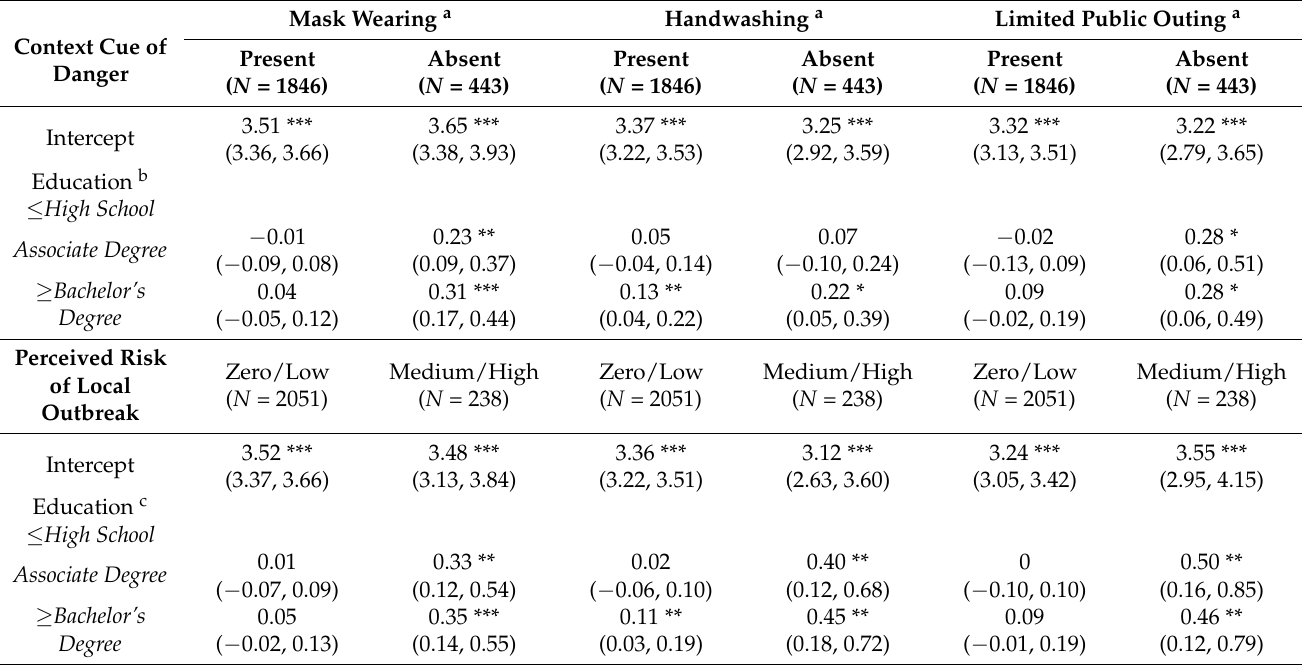
Table 4. Educational Disparities in COVID-19 Preventive Behaviors Stratified by Context Cues of Danger, The Subsample Excluding Wuhan Residents, The Chinese Survey of COVID-19 Impacts 2020 ( N =